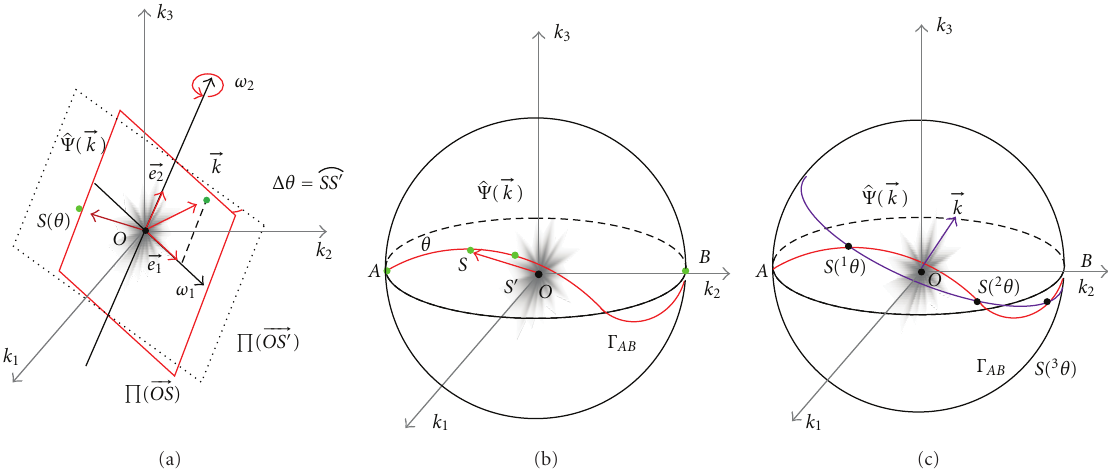
−→ k . When S moves from A to B Γ AB , some region